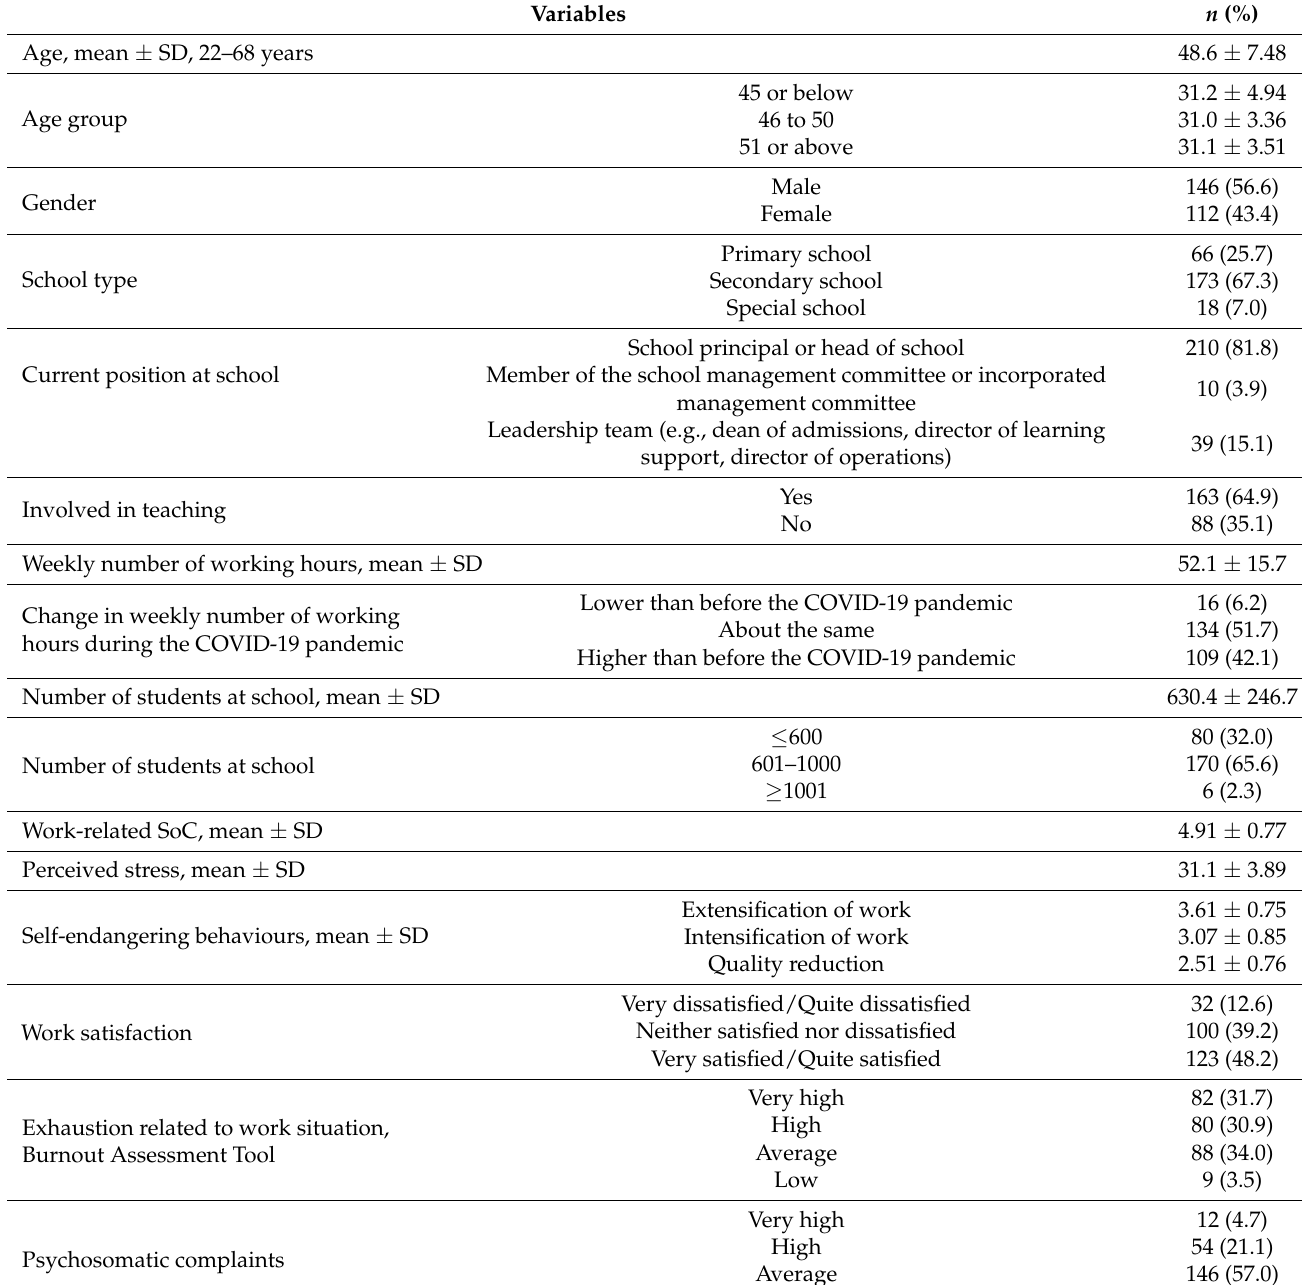
Table 1. Demographic characteristics, school types and situations, perceived stress, health, self- endangering work behaviours, work-related SoC, and well-being of school leaders ( n =